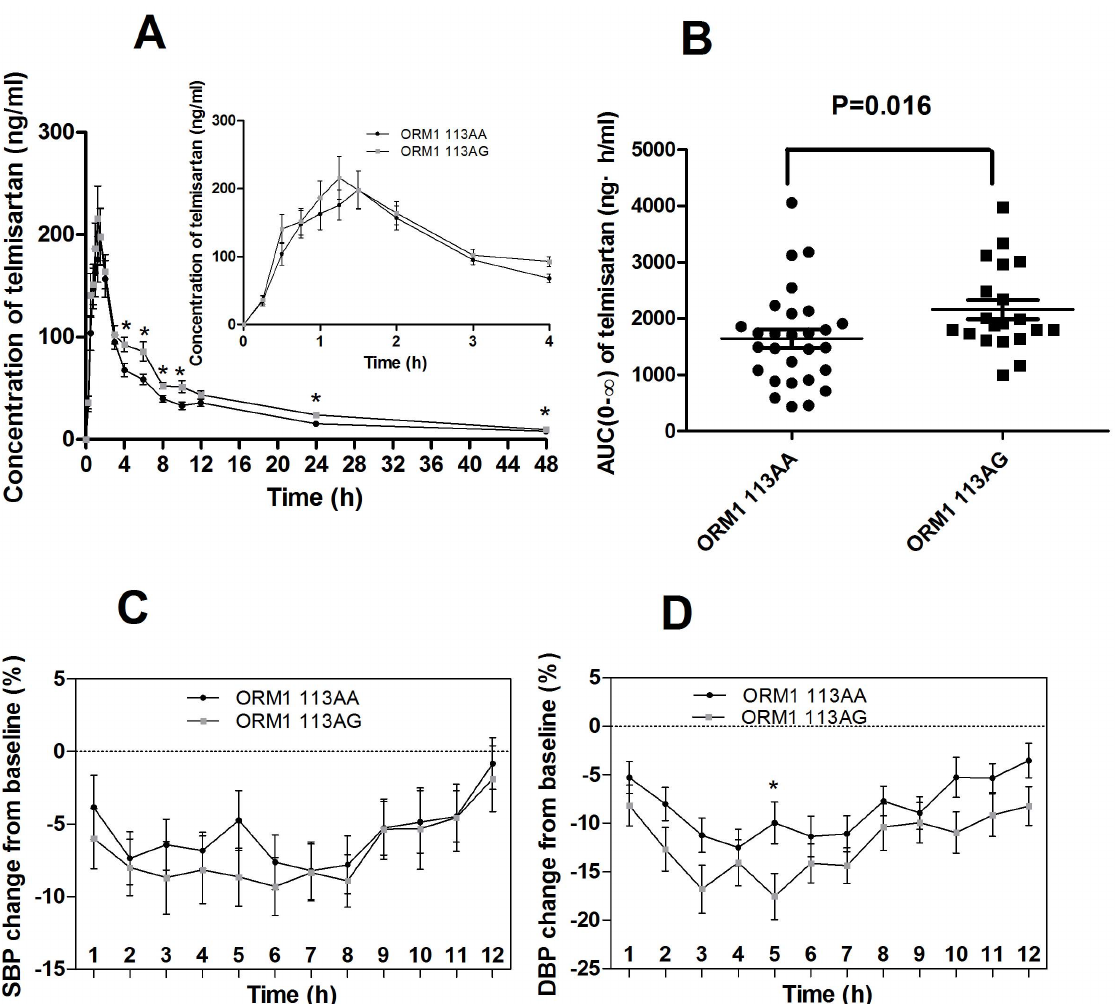
Figure 1. The impacts of ORM1 genotypes on the PKs and BP change(%) after 40 mg telmisartan. A, Concentration; B, AUC (0– ‘ ) ; C, SBP change(%) from the baseline; D, DBP change(%) from the baseline.